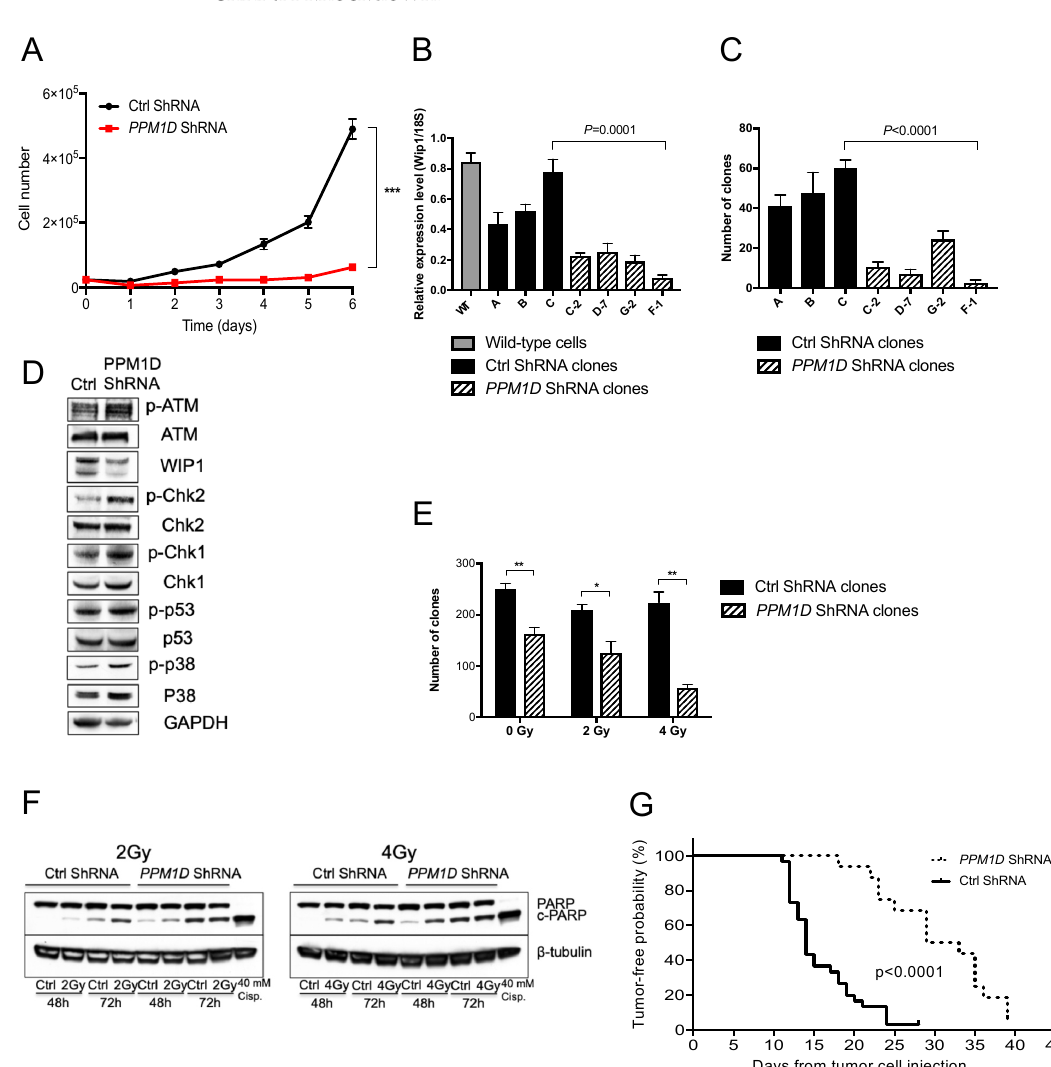
Figure 3. Inhibition of PPM1D expression suppresses tumorigenic capacity and sensitizes neuroblastoma cells to irradiation. ( A ) Knockdown of PPM1D with shRNA impairs proliferation of neuroblastoma cell line SK-N-BE(2). Mean with S.D. of three independent experiments is shown ( t -test day 6,*** p < 0.001.) ( B ) Normalized PPM1D mRNA expression in wild-type SK-N-BE(2) cells (grey bar) compared to three clones transfected with a non-silencing control shRNA (black bars, A – C ) and four different PPM1D shRNA knockdown clones (hatched bars, C-2, D-7, G-2 and F-1). The expression of PPM1D mRNA was significantly lower in the clones transfected with the different PPM1D shRNAs compared to the control transfected clones (one-way ANOVA with Bonferroni correction p < 0.05). Mean with S.D. of three determinants is shown. ( C ) Knockdown of PPM1D inhibits colony-forming ability of neuroblastoma cells. Clonogenic assay of SK-N-BE(2) cells showing decreased colony formation in shRNA PPM1D knockdown cells (one-way ANOVA with Bonferroni post-test p < 0.0001) with lowest colony-forming ability in the F-1 clone ( t -test p < 0.0001). Mean with S.D. of nine determinants is displayed. ( D ) Knockdown of PPM1D inhibits dephosphorylation of WIP1 target genes. Phosphorylation levels of WIP1 targets increased after PPM1D knockdown (clone F-1) compared to control transfected cells (clone C), as shown by Western blotting. ( E ) PPM1D downregulation sensitizes neuroblastoma cells to irradiation. PPM1D knockdown of SK-N-BE(2) cells showed an irradiation dose-dependent decrease in clonogenic capacity compared to control transfected cells. Mean with S.D. of three experiments ( t -test, * p < 0.05, ** p < 0.01). ( F ) ShRNA-mediated knockdown of PPM1D increases irradiation-induced apoptosis. Protein expression of the pro-apoptotic marker cPARP in PPM1D knockdown cells compared to control transfected cells 48 and 72 h after exposure to irradiation, analyzed by Western blot. β -tubulin was used as protein loading control. Cisplatin was used as positive control. ( G ) Knockdown of PPM1D delays neuroblastoma development. Clone F-1 and control clone C were injected subcutaneously in NMRI nu/nu mice (shRNA, n = 8; control, n = 15), 5 million cells